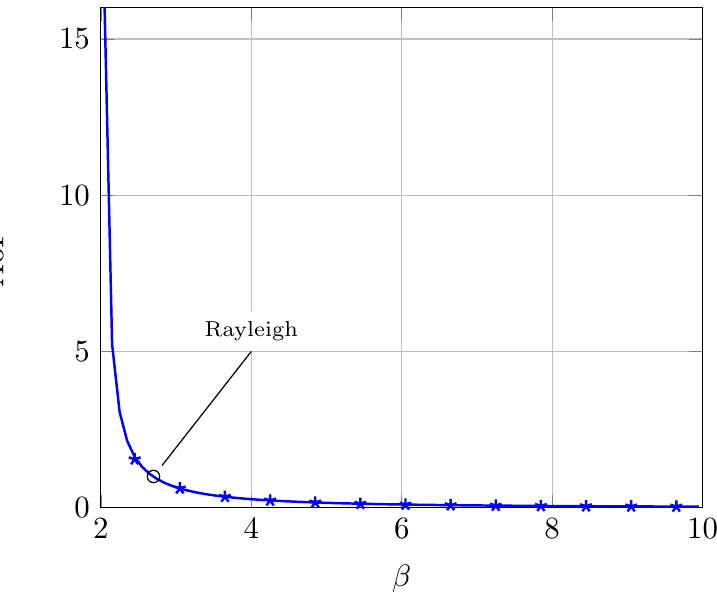
Figure 2. Amount of fading under L -distributed fading for different values of β . The case of Rayleigh fading is included as a reference. Solid lines correspond to the theoretical AoF expression in (7). Markers denote MC simulations.